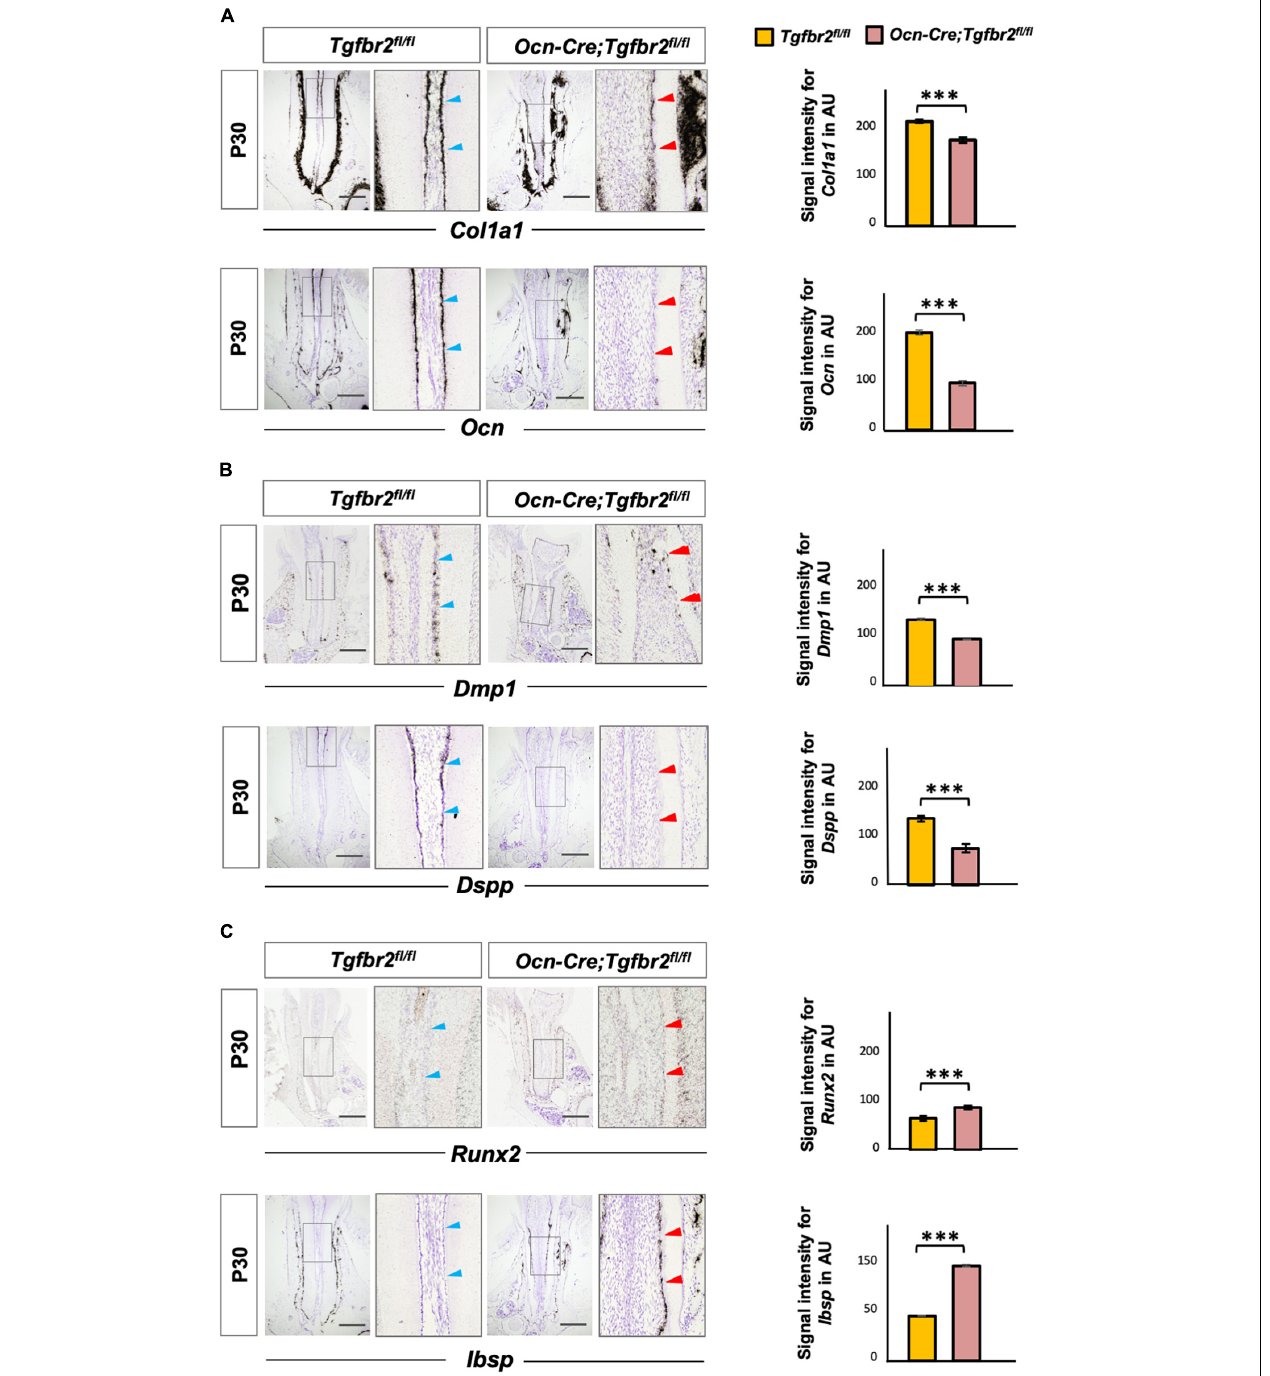
FIGURE 2 | Decreased expression of odontogenic markers and ectopic expression of osteogenic markers in Ocn-Cre ; Tgfbr2 fl / fl mice. (A) Decreased expression of Col1a1 and Ocn in the root odontoblasts of Ocn-Cre ; Tgfbr2 fl / fl mice were indicated by red arrowheads, as compared to that in the Tgfbr2 fl / fl littermates at P30 (blue arrowheads). (B) Reduced expression of Dmp1 and diminished expression of Dspp in the root odontoblasts of Ocn-Cre ; Tgfbr2 fl / fl mice at P30, red arrowheads indicate. (C) Upregulated expression of Runx2 , and ectopic expression of Ibsp in the root odontoblasts of Ocn-Cre ; Tgfbr2 fl / fl mice at P30, red arrowheads indicate. The right panels show the high-magnification image of the area boxed in gray on the left in (A–C) . The right images of bar graphs are quantification of signal intensity for Col1a1 , Ocn , Dmp1 , Dspp , Runx2 and Ibsp expression as shown in (A–C) , respectively, using ImageJ. Data are presented as the means ± standard deviation (SD). *** P < 0.001, n = 4 areas from three mice. Blue arrowheads indicate expression of differentiation markers in Tgfbr2 fl / fl mice, red arrowheads indicate abnormal expression of differentiation markers in Ocn-Cre ; Tgfbr2 fl / fl mice. AU, arbitrary unit. Scale bars: 100 µ m.